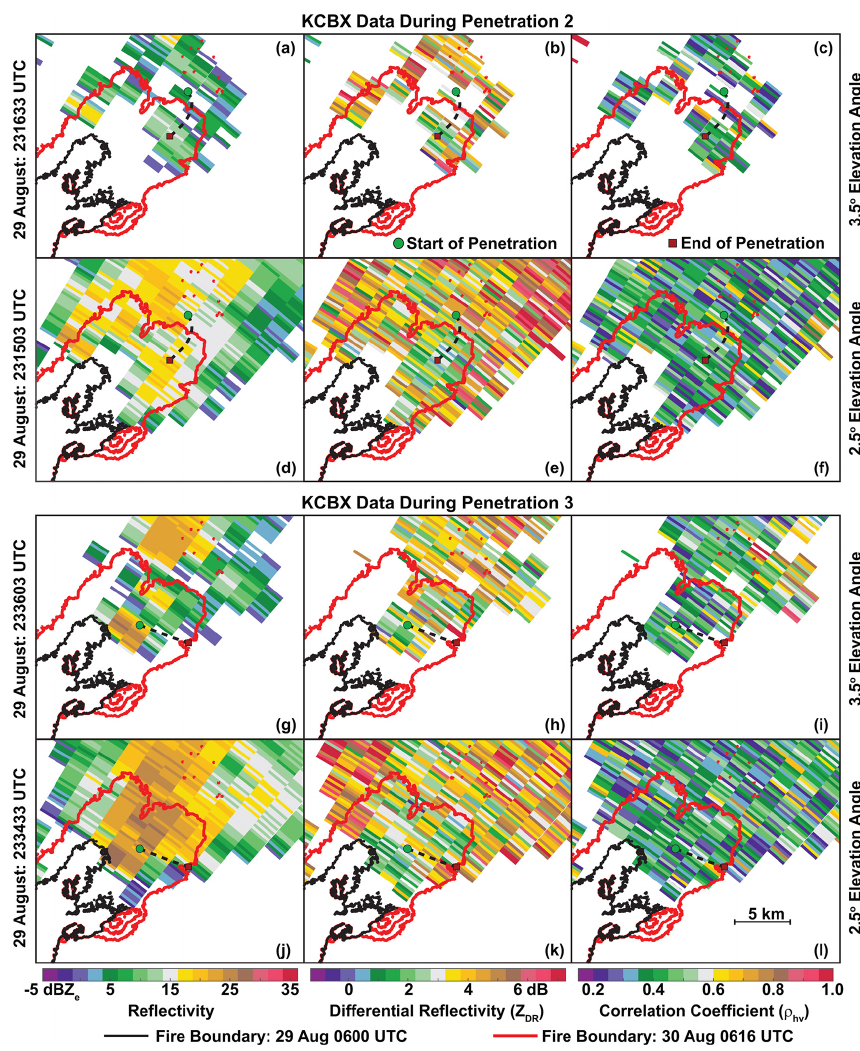
Figure 12. KCBX data approximately coincident with the execution of penetration 2 (a–f) and penetration 3 (g–l) . Left column (a, d, g, j) shows reflectivity, middle column (b, e, h, k) shows differential reflectivity ( Z DR ), and right column (c, f, i, l) shows correlation coefficient ( ρ hv ). Color scales at bottom of each column indicate plotted values. Top row (a–c) is for data at 23:16:33UTC 29 August 2016 (3.5 ◦ elevation angle), second row (d–f) for data at 23:15:03UTC 29 August 2016 (2.5 ◦ elevation angle), third row (g–i) for data at 23:36:03UTC 29 August 2016 (3.5 ◦ elevation angle), and fourth row (j–l) for data at 23:34:33UTC 29 August 2016 (2.5 ◦ elevation angle). Perimeters of the Pioneer Fire at 06:00UTC 29 August 2016 and 06:16UTC 30 August 2016 are indicated with black and red lines, respectively. Dashed black lines show the locations of penetrations 2 and 3, with green circles and red squares indicating the start and end of each penetration,